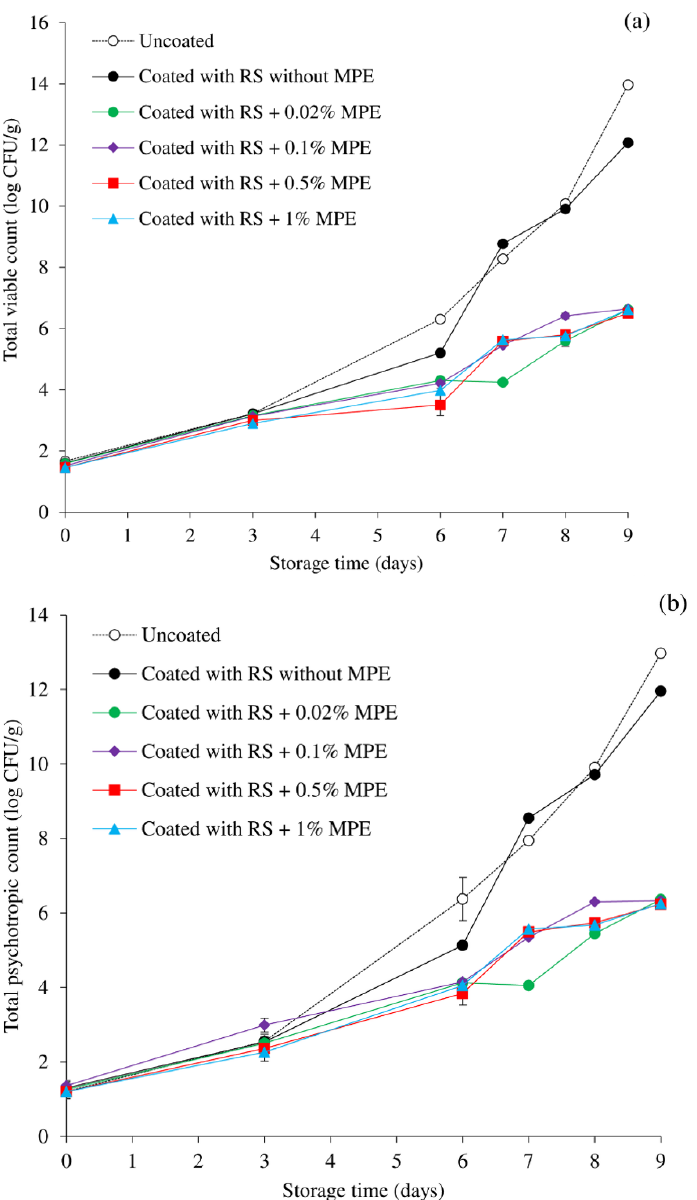
Figure 1. Changes in the total viable count ( a ) and total psychotropic count ( b ) of mackerel slices over the course of storage at 4 °C influenced by coating with rice starch (RS) containing Mon-pu extract (MPE) at different concentrations. Bars represent standard deviation from triplicate deter- minations.